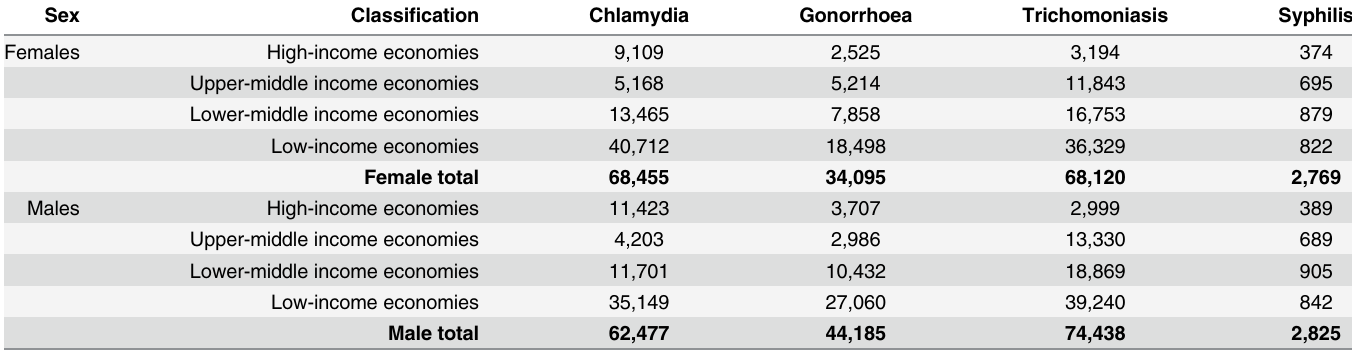
Table 7. Number of incident cases ( ‘ 000) in 2012 by infection and World Bank income classification. Note: Estimates by World Bank classification are not identical to those by geographic region as three countries are not classified by World Bank and were therefore excluded: Cook Islands, Niue, and Nauru.